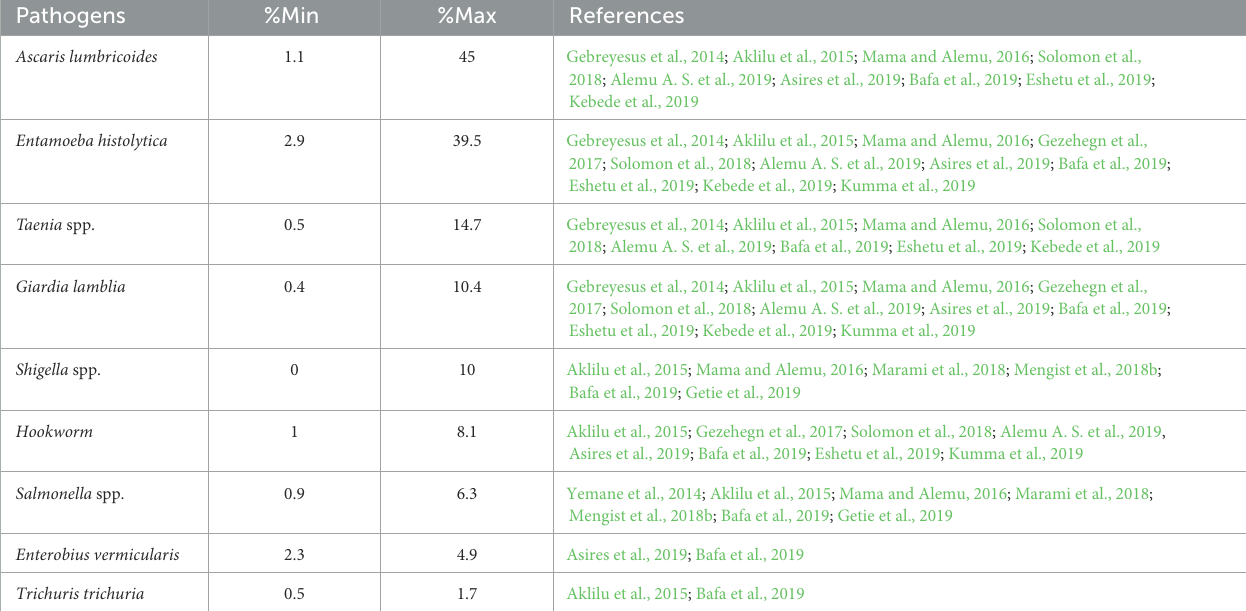
TABLE 3 Pathogens detected from stool samples of food handlers working in food establishments.